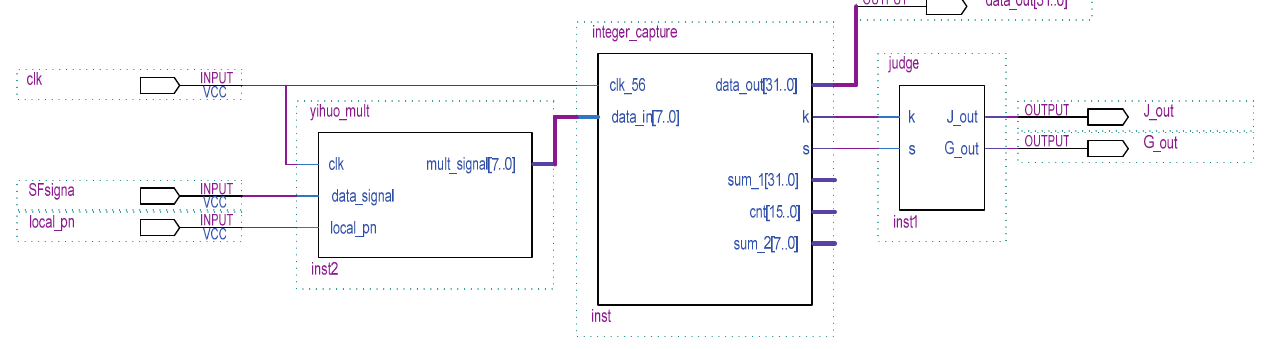
Figure 27. The top-level design of the code acquisition module.